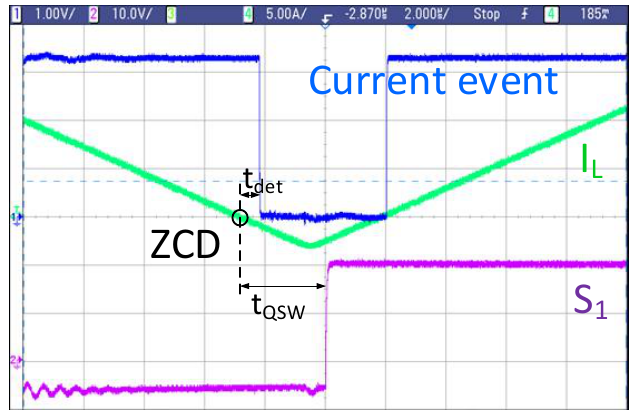
Figure 13. Current event detection based on the current sensor and ZCD. Gate signal S 1 (violet), I L (green) and current event signal (blue).